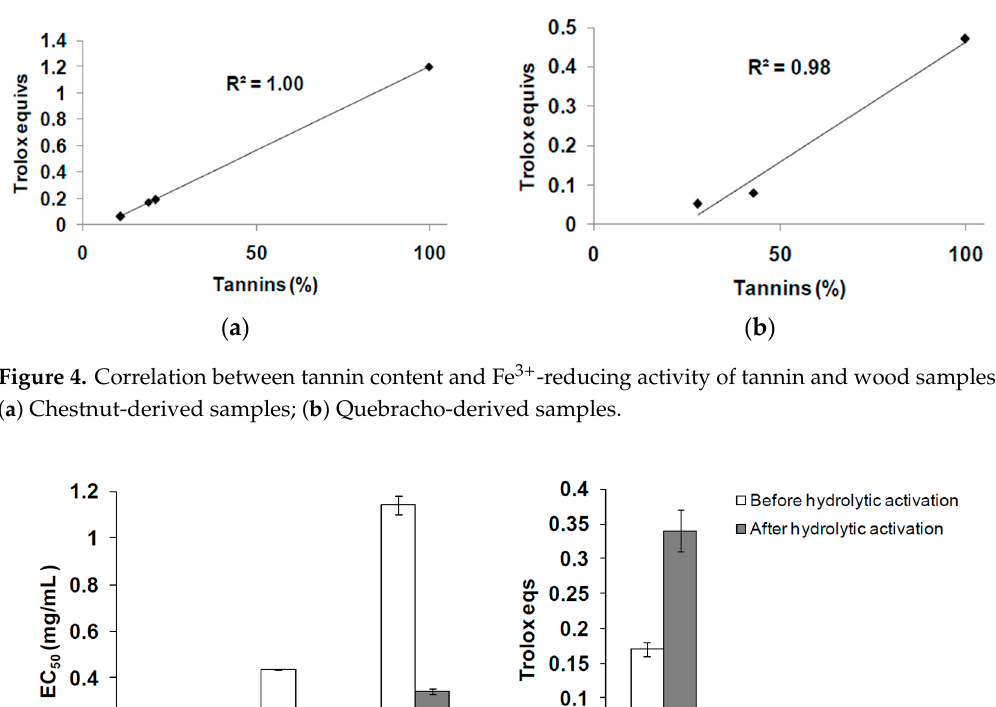
Figure 4. Correlation between tannin content and Fe 3+ -reducing activity of tannin and wood samples. ( a ) Chestnut-derived samples; ( b ) Quebracho-derived samples.